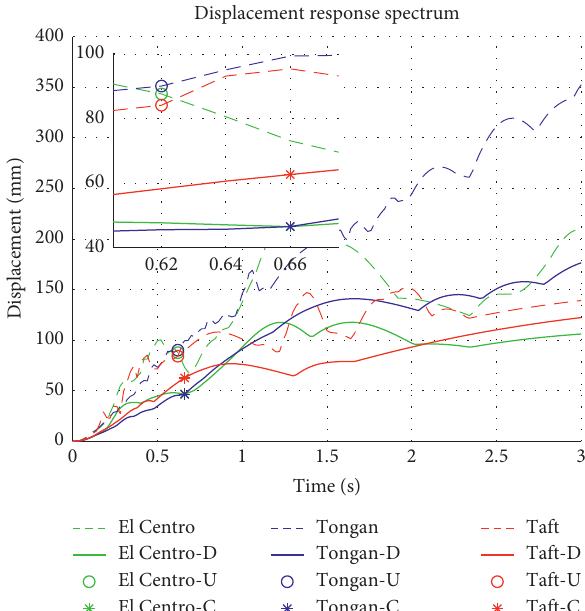
Figure 20: Displacement response spectrum.